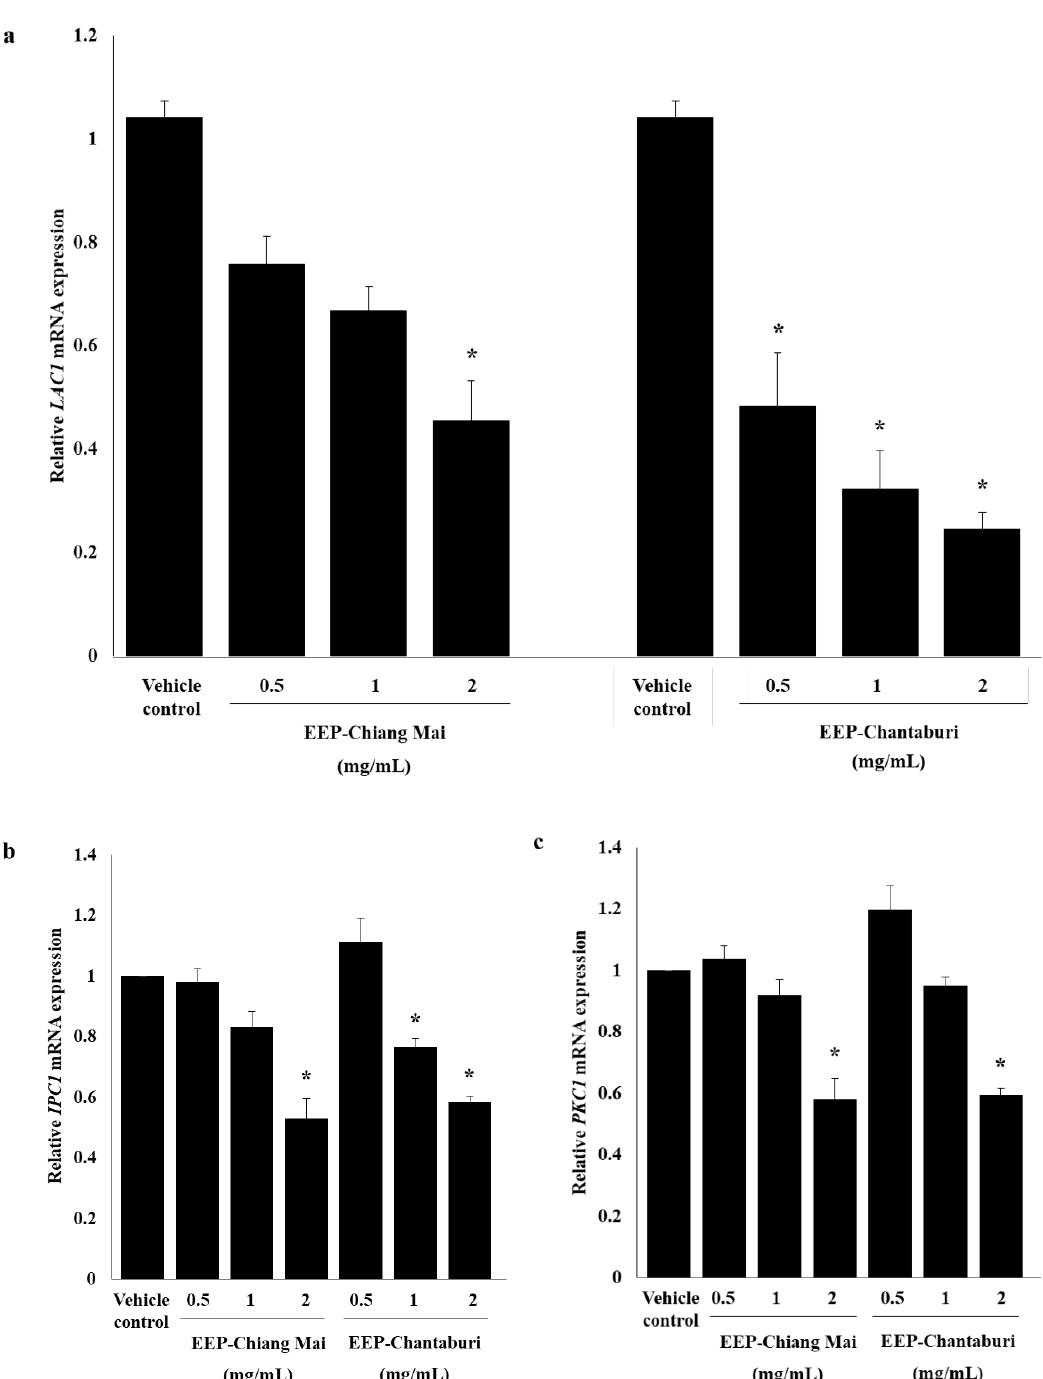
Figure 4. Melanogenesis-related genes mRNA expression of EEP-treated C. neoformans . ( a ) LAC1 gene-related melanin production was determined and normalized with the housekeeping gene level and repressed as a fold change compared to vehicle control. ( b , c ) IPC1 and PKC1 pathway-related melanin production was detected and repressed as a fold change compared to vehicle control. The results are expressed as mean ± SEM of three independent experiments in duplicate. Significant di ff erences (* p < 0.05) when compared with the vehicle control were determined by one-way ANOVA.